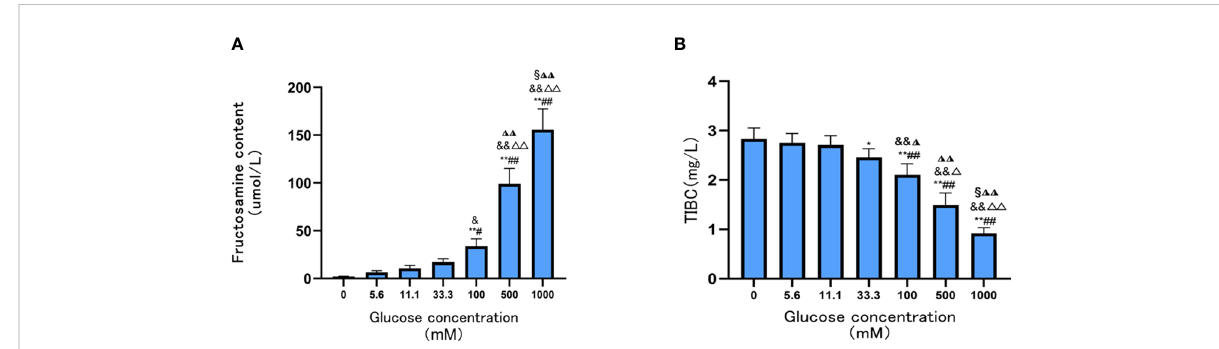
FIGURE 1 Contents of Tf fructosamine and TIBC level prepared under different glucose concentrations. (A) The contents of Tf fructosamine prepared under different glucose concentrations; (B) TIBC levels of Tf prepared at different glucose concentrations. Compared with 0mM group, *P < 0.05, **P < 0.001;Compared with the 5.6mM group, #P < 0.05, ##P < 0.001;Compared with the 11.1mM group, &P < 0.05, && P < 0.001; Compared with the 33.3mM group, ◮ P < 0.05, ◮◮ P < 0.001; Compared with the 100mM group, △ P < 0.05, △△ P < 0.001; Compared with the 500mM group, §P <